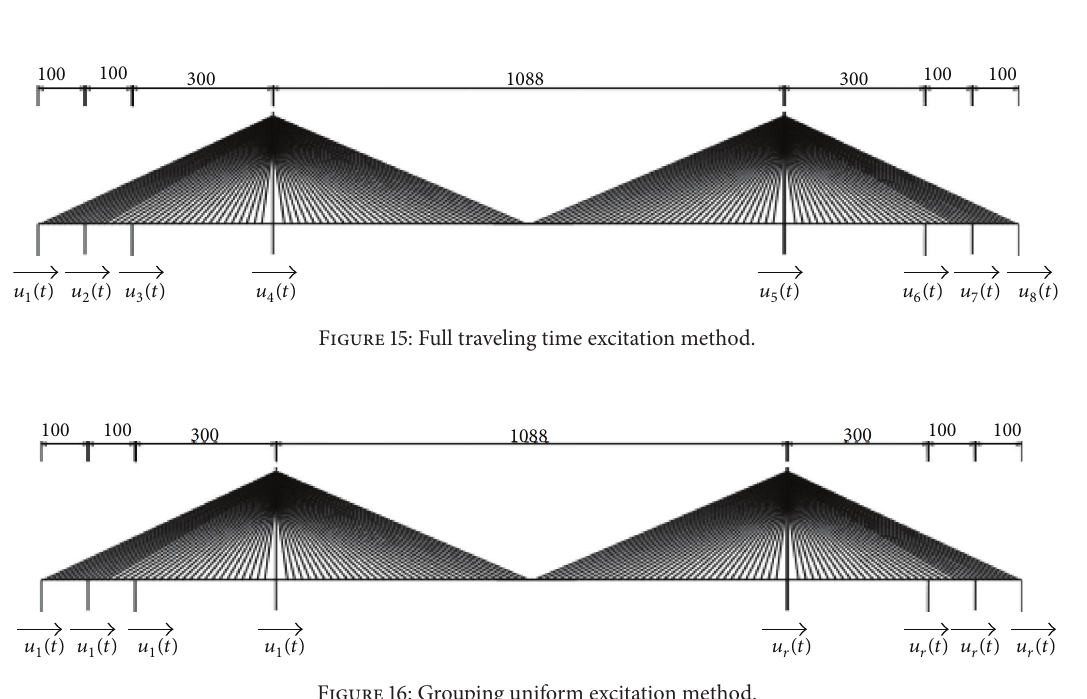
Figure 14: Variation trend of peak structural seismic responses with apparent wave velocity under the excitation of 𝑐 1 .